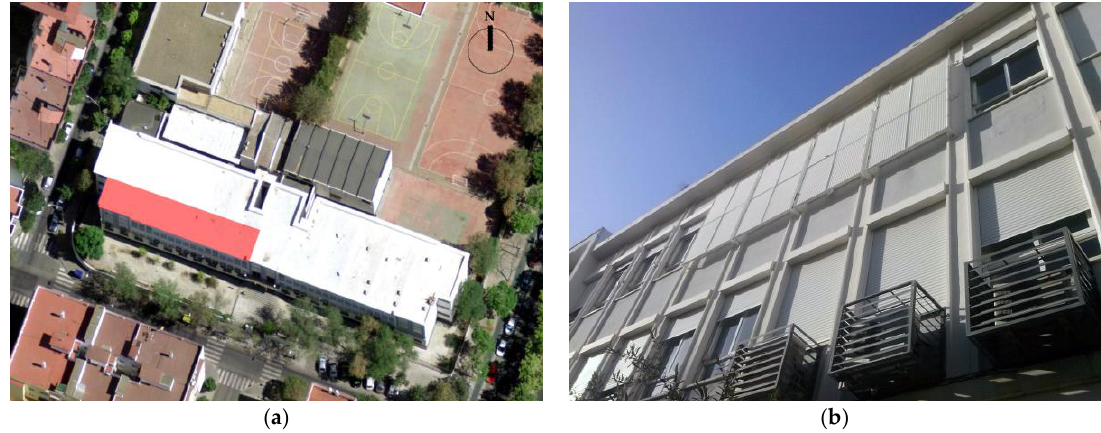
Figure 1. ( a ) Martínez Montañés Secondary School. The module of the classrooms monitored is shown in red. Base image: Google Earth Pro, 26 July 2017; ( b ) outdoor image of the rooms monitored: the four windows on the left, room without shading devices; the four windows on the right, and room with shading devices.